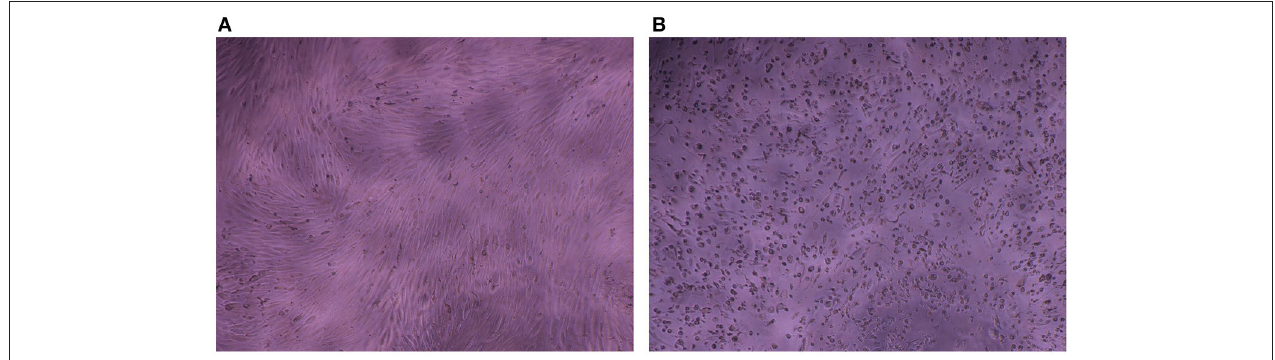
FIGURE 5 | Effect of the infection protocol used on the CI values. Significant effect of the medium used for HAV infection was found on the CI min ( p = 0.0026) and CI max ( p < 0.0001) using a one-way ANOVA. Multiple comparison analysis testing displayed population marginal means with standard error of CI min (A) and CI max values (B) . Two means are significantly different if their intervals are disjoint and are not significantly different if their intervals overlap.